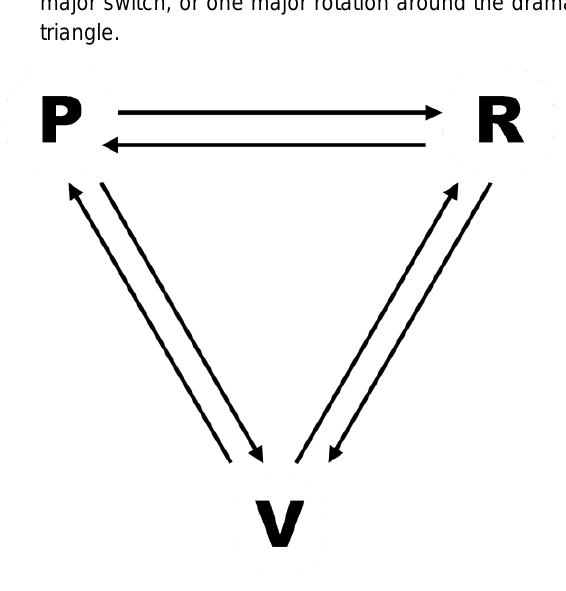
Figure 1: Drama Triangle (Karpman 1968 p.